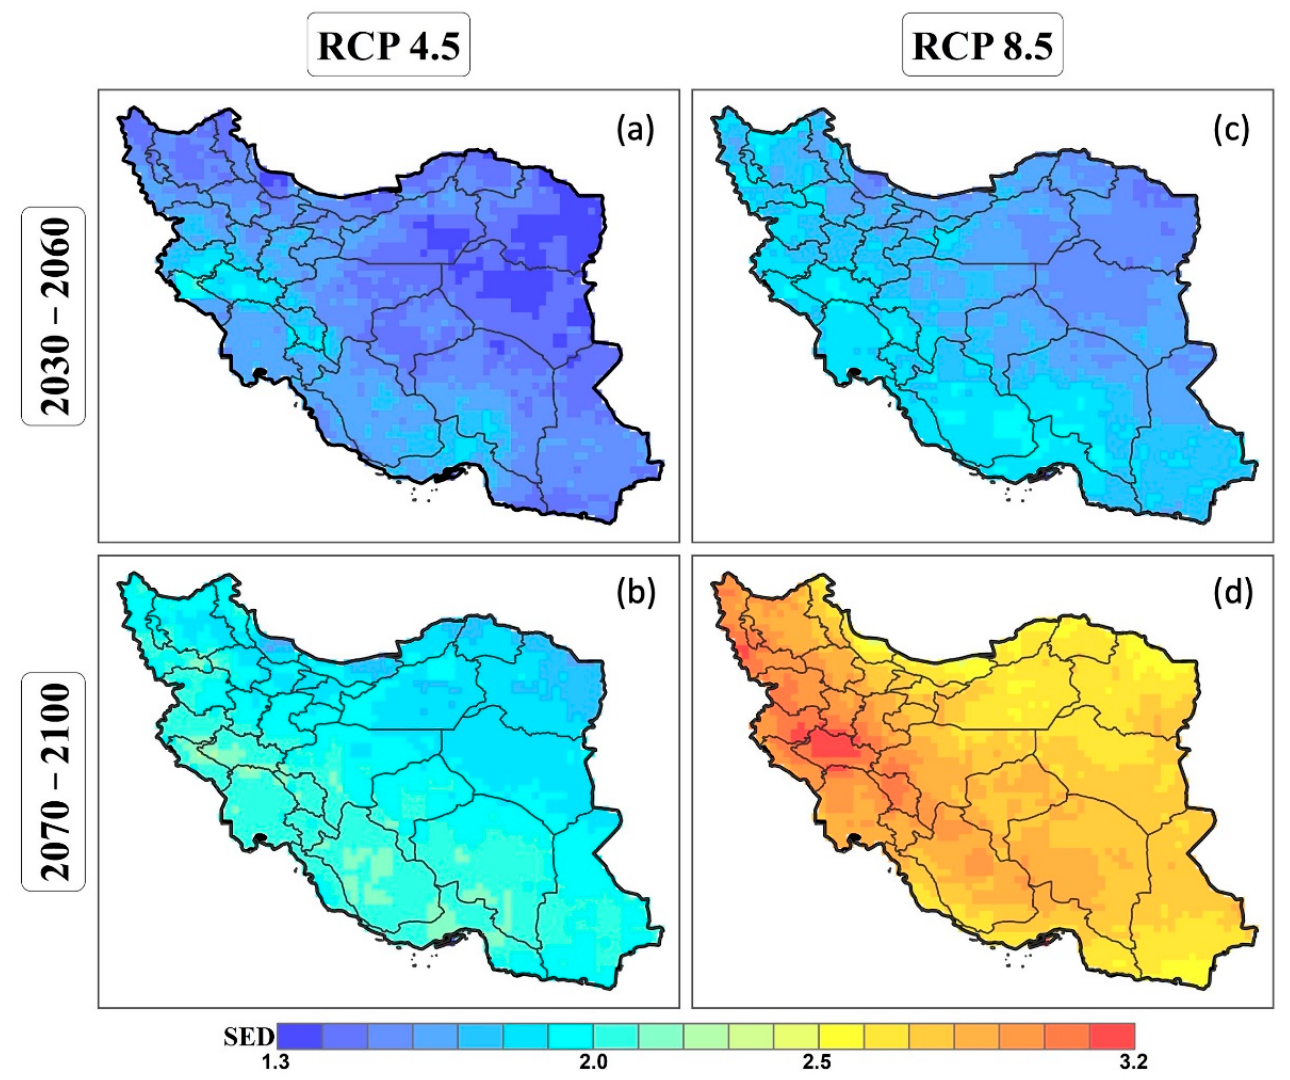
Figure 3. Hotspot pattern over Iran for the 2030–2060 and 2070–2100 periods under RCP4.5 ( a , b ) and RCP8.5 ( c , d ). Unitless.